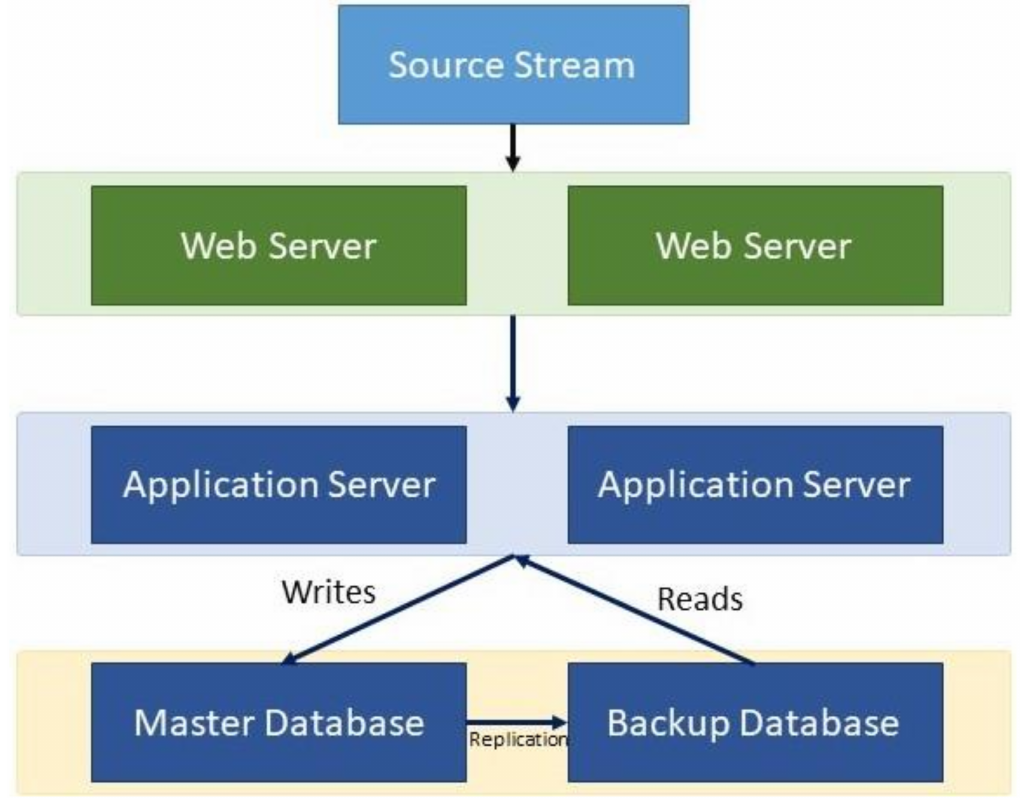
Figure 4. Conventional food tracking systems